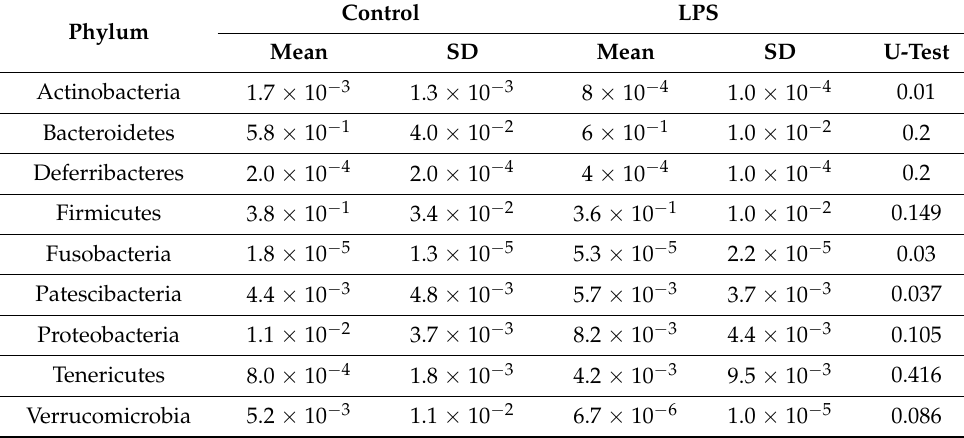
Figure 6. Myelin basic protein (MBP) expression level in the prefrontal cortex and thalamic nucleus in maternal immune activation (MIA) male offspring. ( A ) The MBP expression level in the prefrontal cortex and ( B ) thalamic nucleus of control and MIA offspring (lipopolysaccharide—(LPS) group) was detected with immunohistochemistry staining. The MBP expression level in whole brain slices are shown in the upper pictures. The MBP expression level in prefrontal cortex and thalamic nucleus are shown in the lower pictures. The quantification of the MBP + area in the prefrontal cortex and thalamic nucleus is shown in the bar graph. * p < 0.05 ( n = 4 per group). All data are presented as mean ± SEM. Scale bar, 100 µ m. Table 1. Phylum-level microbiome composition in the feces of control and maternal immune acti- vation male offspring. The relative abundance of microbiomes in phylum level from the feces of control and LPS MIA offspring were obtained from 16S rRNA gene sequencing data. The significant difference of group was statistically calculated by U-test. SD: standard deviation.